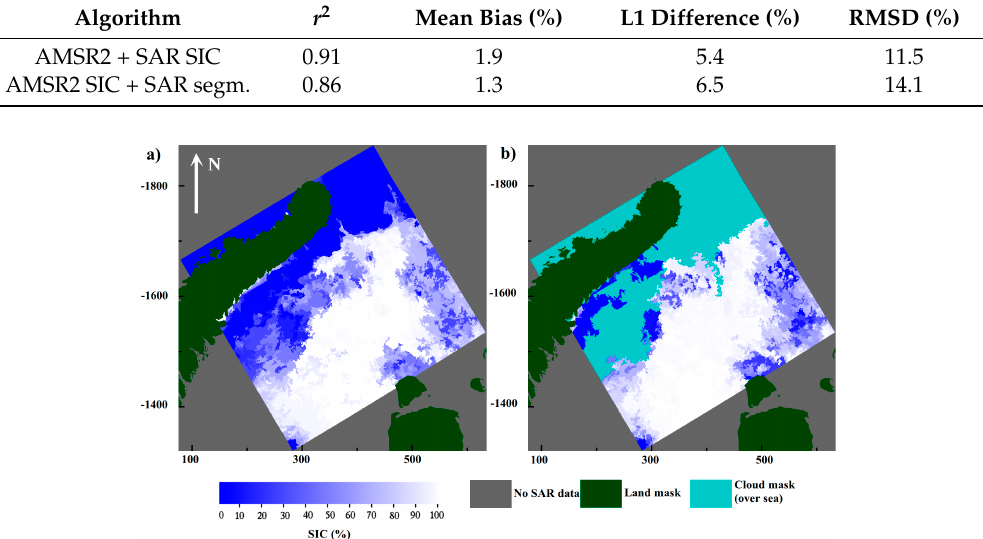
Table 4. Validation statistics for the sea ice concentration estimation using the SENTINEL-1 SAR and AMSR2 radiometer data and two different algorithms: AMSR2 + SAR SIC and AMSR2 SIC + SAR segm. Sea ice concentration validation data were retrieved from the MODIS OWSI charts for March to